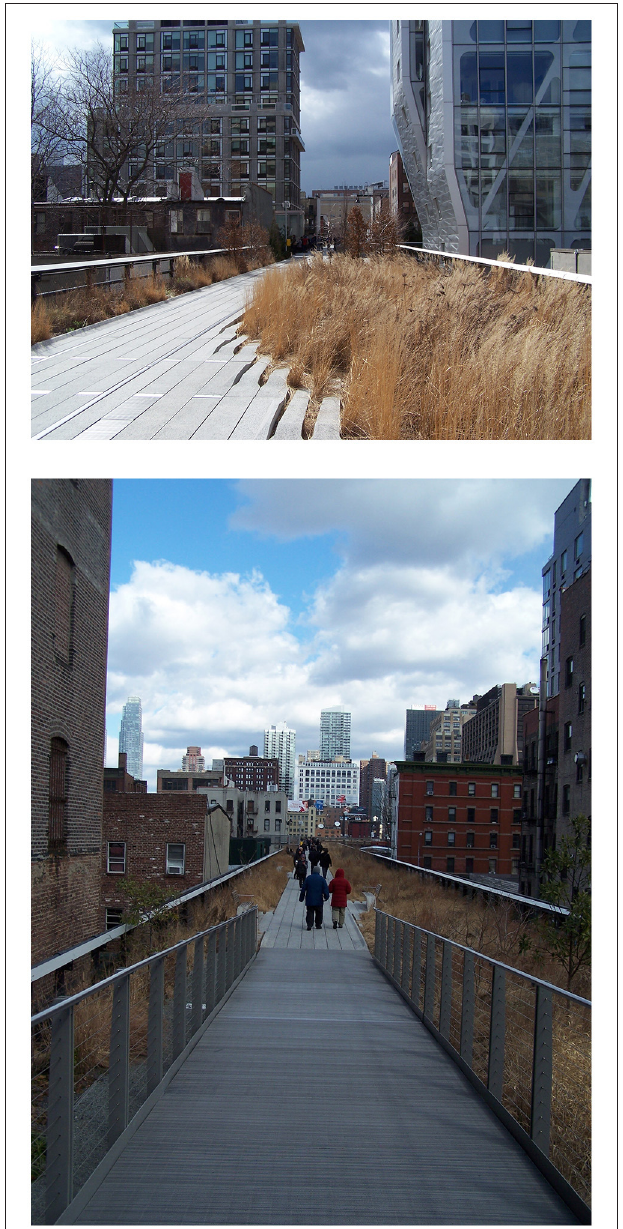
FIGURE 3 | The High Line, New